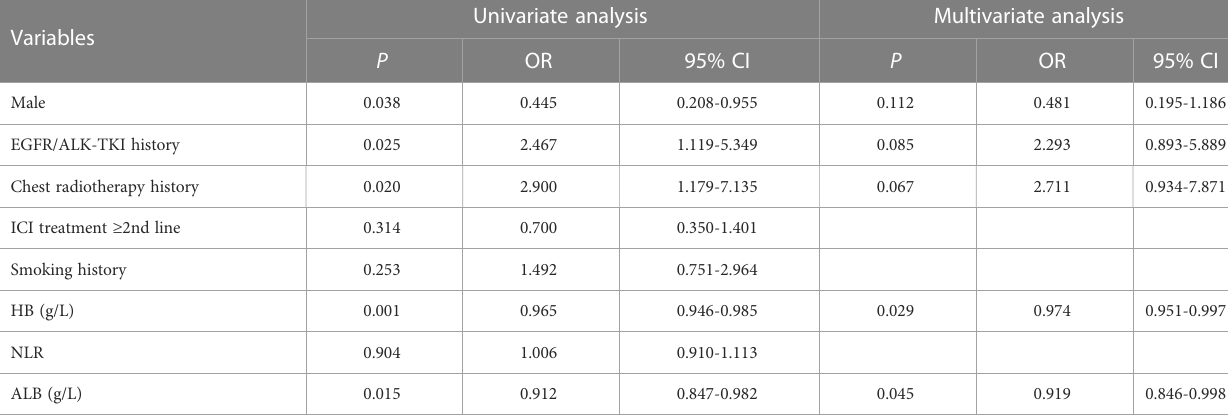
TABLE 3 Analyses of risk factors for the occurrence of CIP.